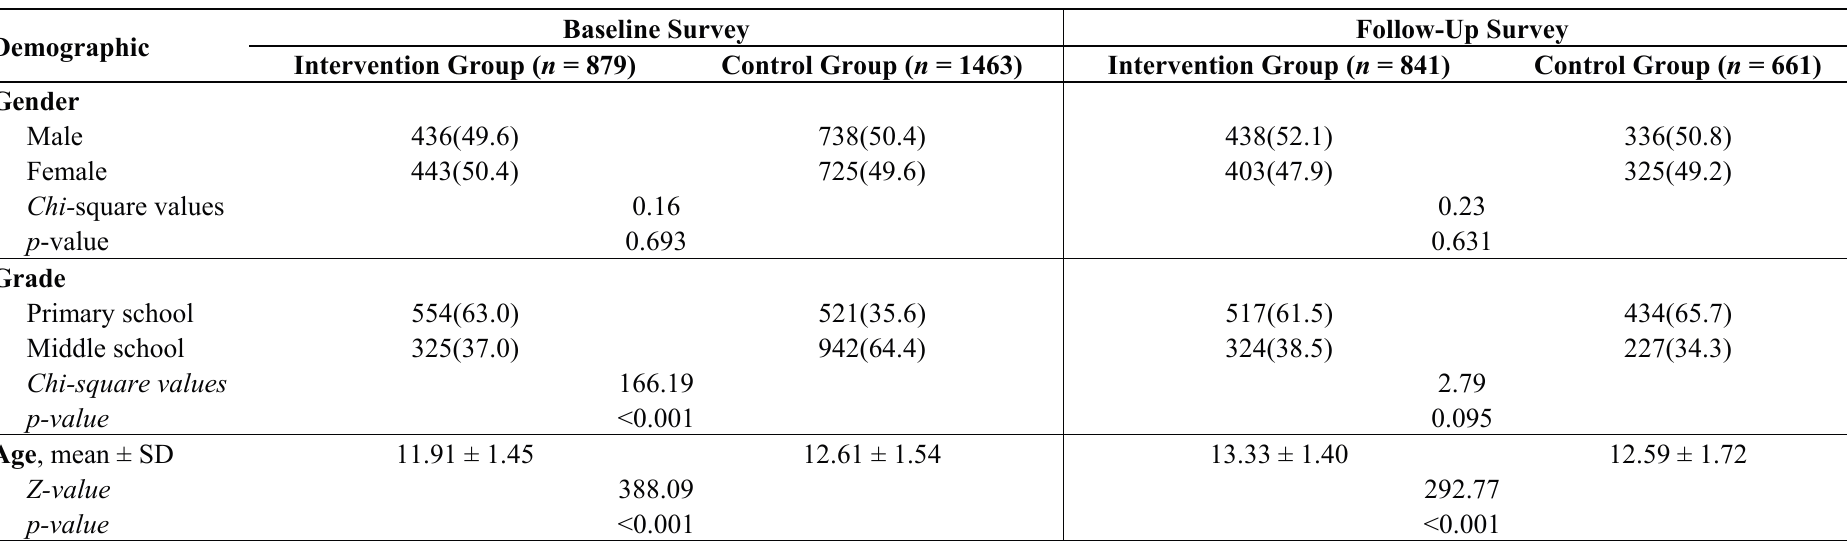
Table 1. Basic characteristics of students for baseline and follow-up surveys of knowledge and attitudes about accidental injury.